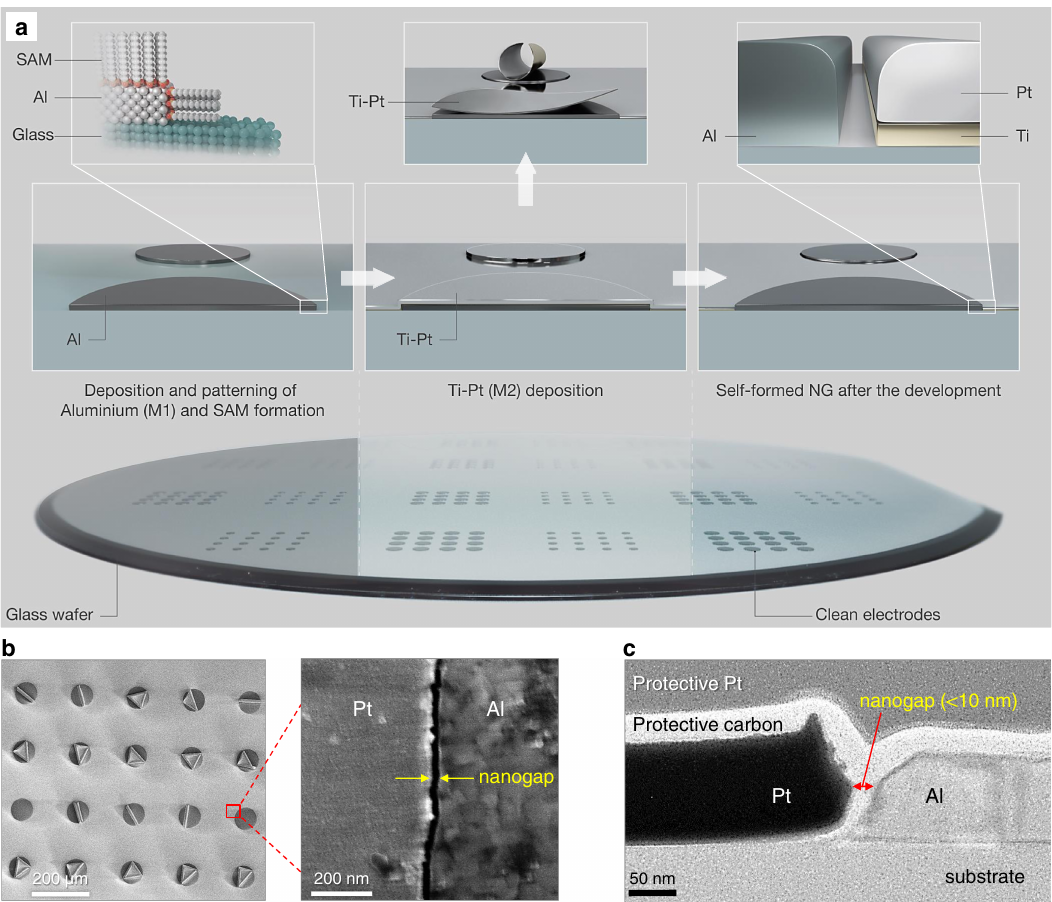
Fig. 1 Fabrication of self-forming nanogap electrodes. a Schematic illustrations of wafer scale nanogap electrodes fabrication. The key steps involved the patterning and selective SAM formation on Al electrodes (left) followed by Ti-Pt deposition (middle), resulting the self-peeling of Ti-Pt fi lms on Al/SAM surfaces (right). b SEM image displaying the self-peeling of Ti-Pt only on top of Al/SAM surfaces and reveals nanogap between Al and Ti-Pt metals. c High-resolution cross-sectional TEM images showing the nanogap (<10 nm) between Al/Ti-Pt